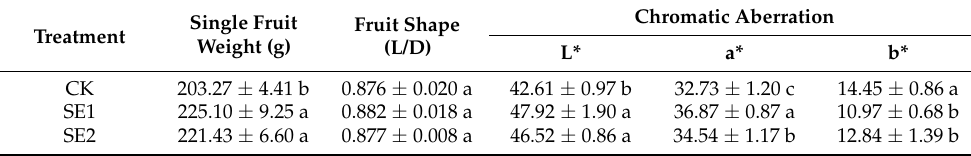
Table 2. Effects of organic fertilizer on the appearance quality of the apple fruit.